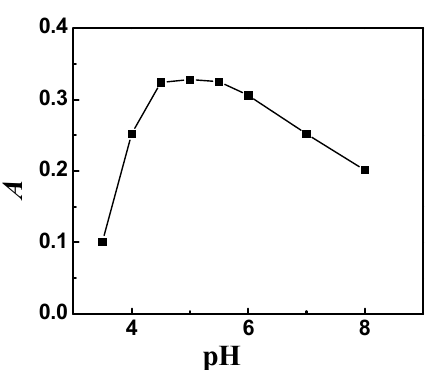
Figure 1. Effect of pH on absorbance (peak area). Thirty nanogram Ni; 0.25 mL 5 × 10 − 4 mol L − 1 2-(5-bromo-2-pyridylazo)-5-dimethylaminoaniline (5-Br-PADMA); 1.0 mL 0.5% ( m / v ) sodium lauryl sulfate (SLS); 0.80 mL 1.0 % ( m / v ) Triton X-114; temperature: 60 °C; heating time: 10 min.